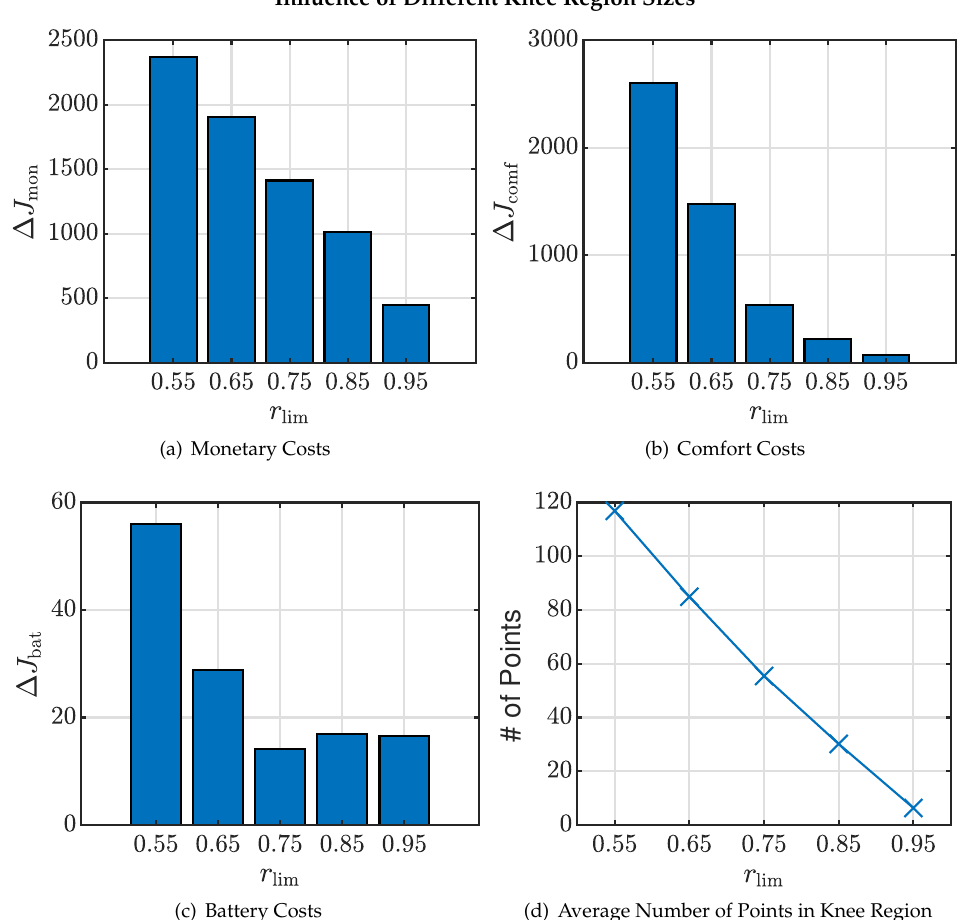
Figure 12. Maximum difference in total monetary ( a ), comfort ( b ) and battery ( c ) costs and the average number of points considered to be part of the knee region ( d ) for different r lim , which were calculated according to